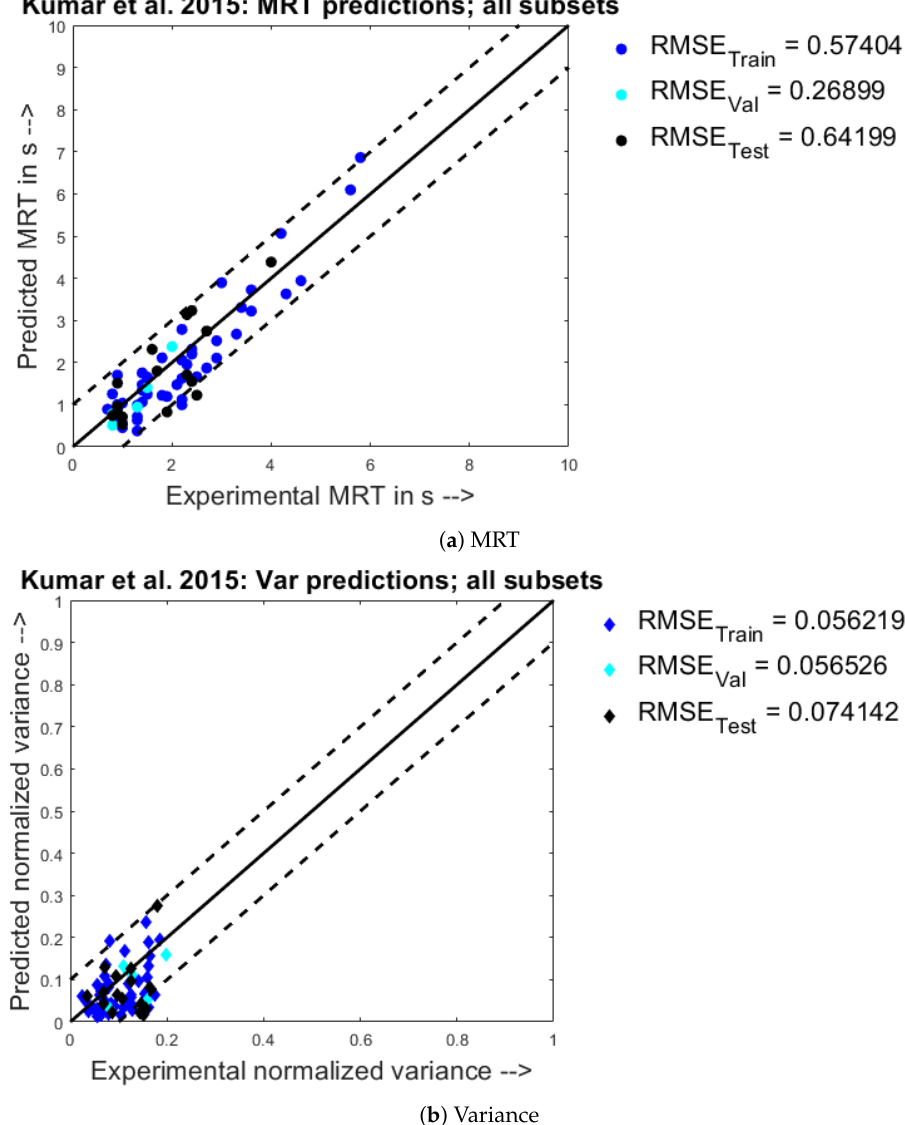
Figure 8. Experimental observations (X) vs. predicted model responses (Y) when trained on the Kumar et al. 2015 [21]